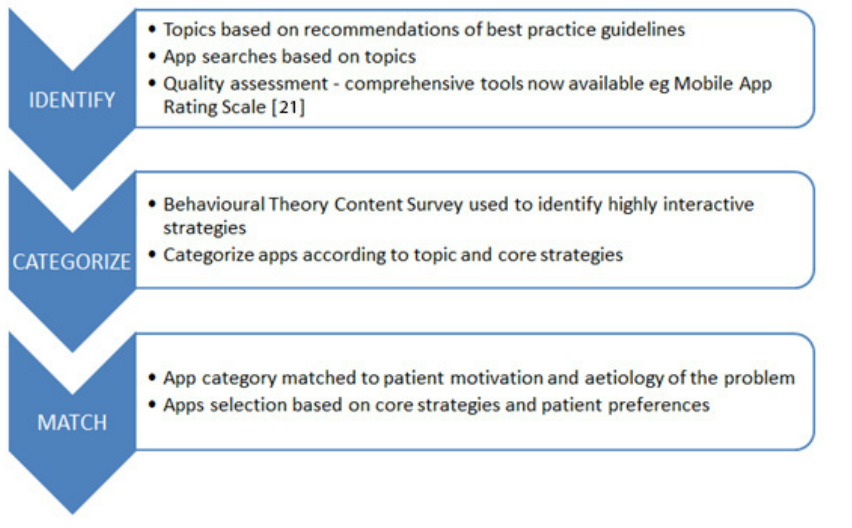
Figure 1. Framework for selecting, categorizing, and matching apps to patients'